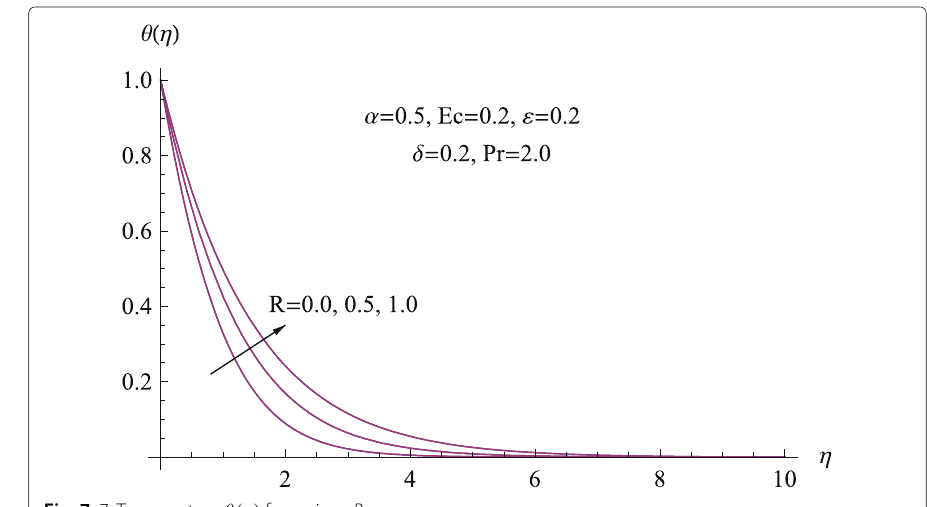
Fig. 7 7. Temperature θ(η) for various R